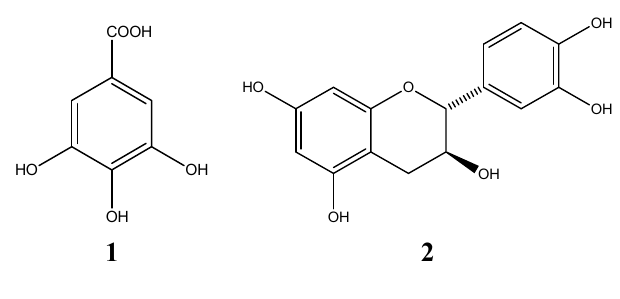
Figure 1. The structures of the compounds isolated from Pu-erh